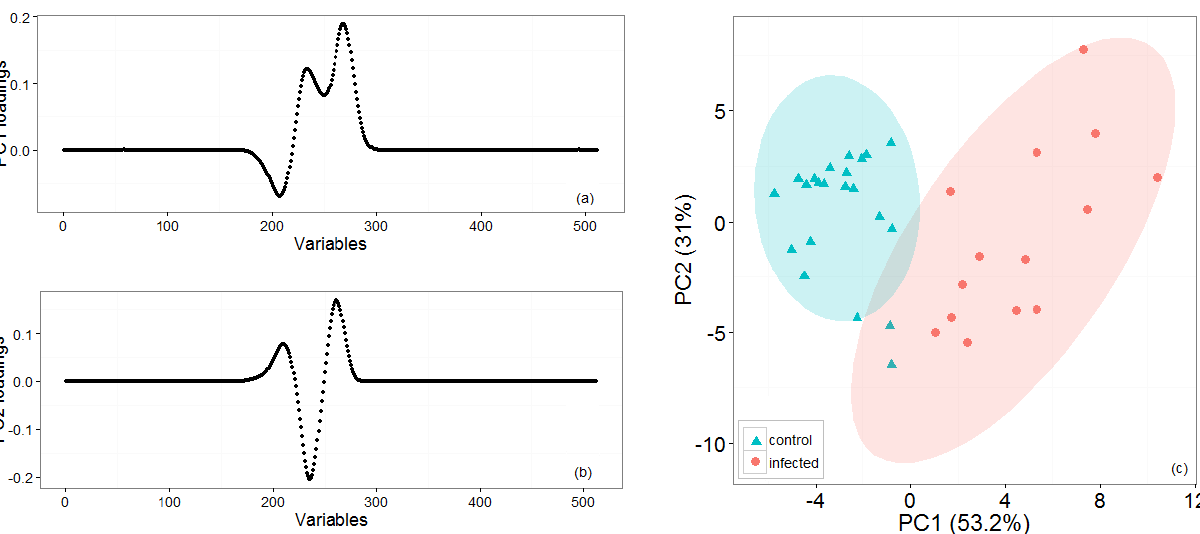
Figure 4. Second set of experiments: loading plots ( a , b ) for the two first principal components that account for most of the variance. ( c ) PCA and k-means clustering for two groups of potato tubers, with controls (cyan triangles) and infected (red circles) which have been grouped with 95% confidence ellipses around the centroid identified by the k-means